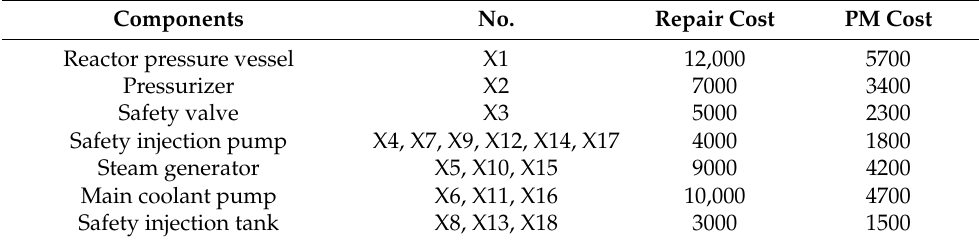
Figure 3. Component maintenance priority in the case of multiple component failures. Table 3. Maintenance cost and preventive maintenance cost of each